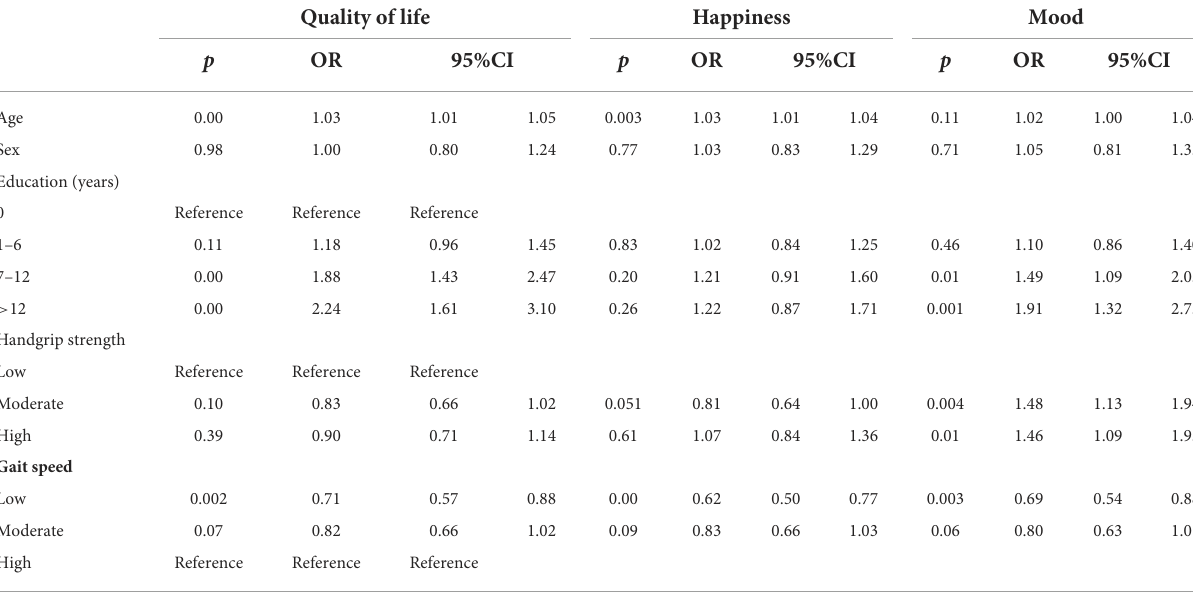
TABLE 2 The association between physical performance and wellbeing estimated by logistic regression models. Quality of life Happiness